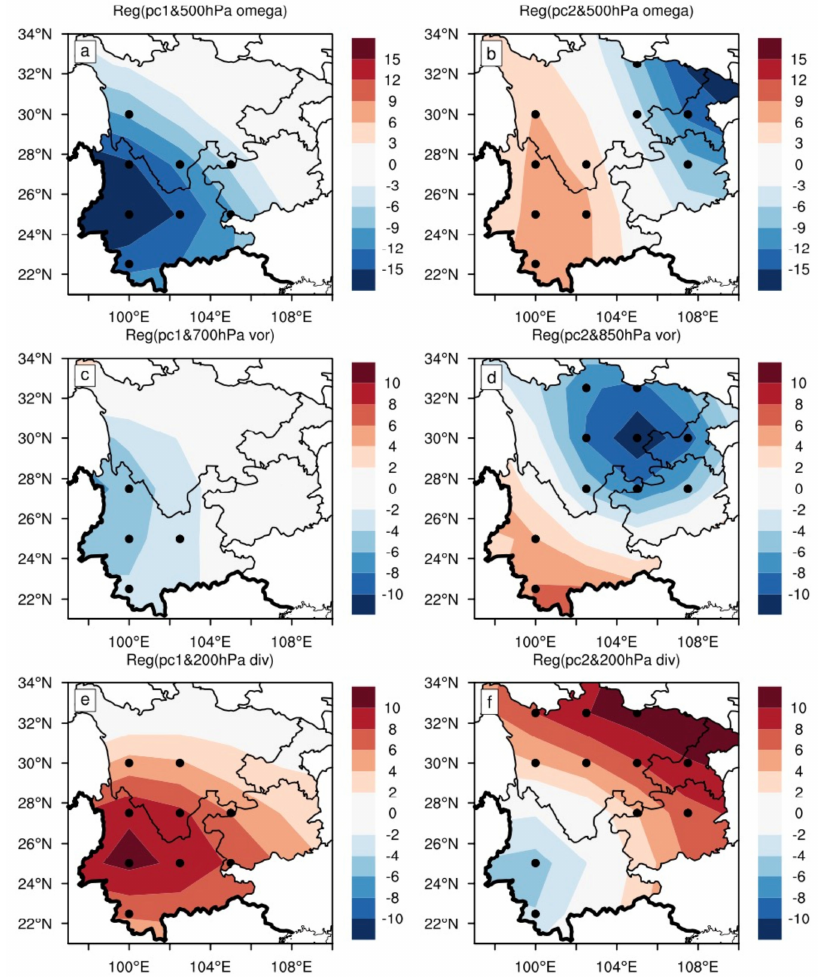
Figure 4. Regressed anomalies of interannual components of ( a ) 500 hPa omega (unit: 10 − 3 Pas − 1 ), ( c ) 700 hPa vorticity (unit: 10 − 7 s − 1 ) and ( e ) 200 hPa divergence (unit: 10 − 7 s − 1 ) in late spring onto the interannual components of the PC1 for the period of 1960 to 2018. ( b ) As in ( a ), but for PC2; ( d ) As in ( c ), but for 850 hPa vorticity and PC2; ( f ) As in ( e ), but for PC2. The black spots denote the values have passed the 95% confidence level.